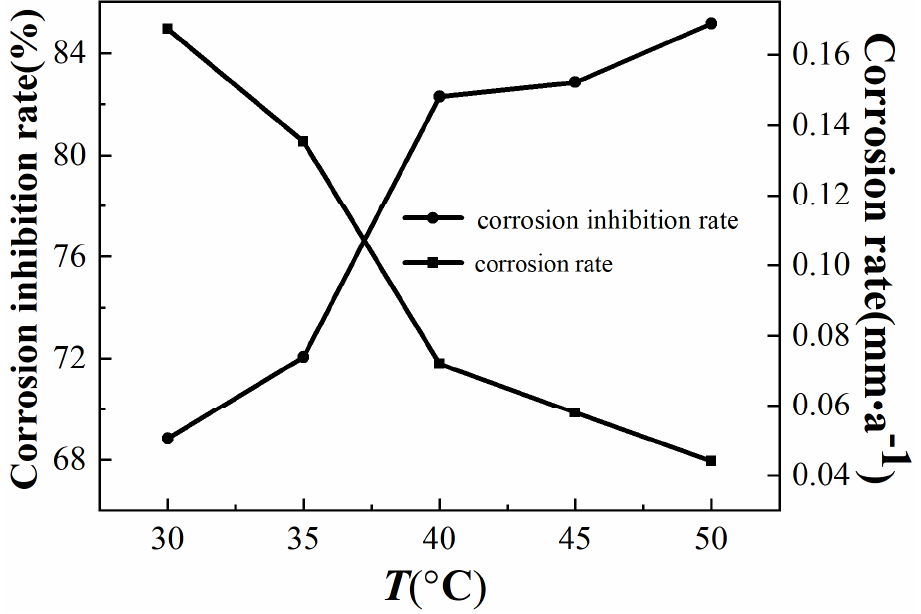
Figure 8. Influence of water sample temperature on corrosion inhibition. With increasing temperature, the corrosion inhibition effect of copolymer scale in- hibitor on carbon steel surface gradually increases. The adsorption of copolymer scale inhibitor on the carbon steel surface is an endothermic reaction. When the temperature rises to a certain level, the increasing trend of corrosion inhibition rate slows down because the adsorption behavior of copolymer on carbon steel surface decreases at a higher tem- perature. If the temperature continues to increase, desorption may occur, and the effective coverage of the adsorption film decreases [22]. When the temperature is relatively low, the equilibrium of adsorption and desorption can be shifted in the direction of adsorption by increasing the